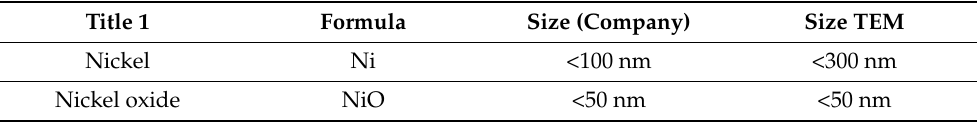
Table 2. Comparison of particle sizes between the particle sizes given by the manufacturers and our measurements. Our observations show that the input size of nickel given by the manufacturer does not correlate with our